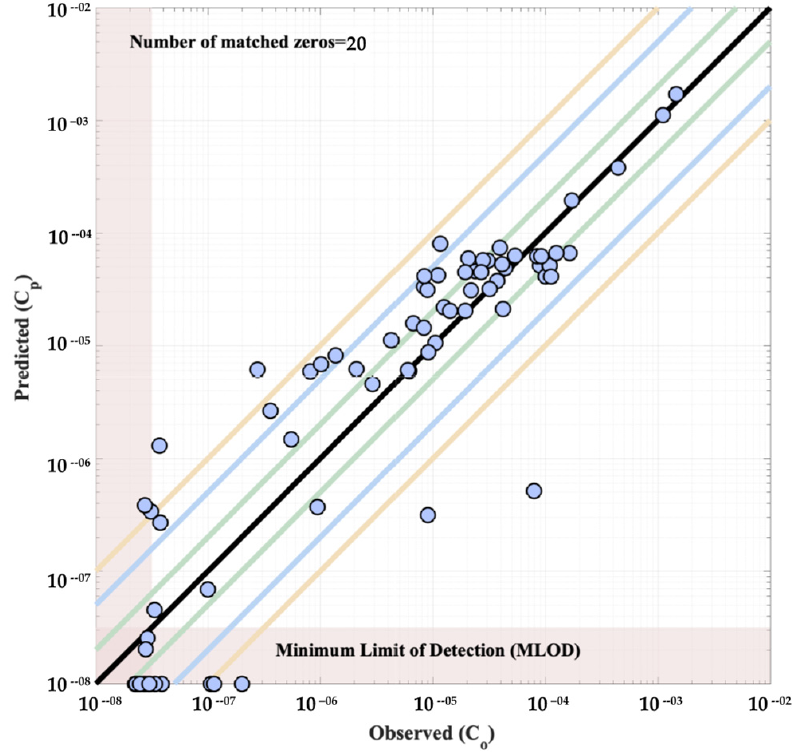
Figure 10. Scatter plot showing points paired in time and space for predicted and observed 30 min averaged SF 6 concentrations (g/m 3 ) for IOP 8 trial 2 during the Joint Urban 2003 field experiment. Further quantitative analysis of our results is given in terms of absolute value of fractional bias (|FB|) and the normalized mean square error (NMSE) for concentration. Fractional bias is a normalized value of mean error [26]. |FB| values range from 0 to +2. A perfect agreement between model and measurement would result in FB = 0.